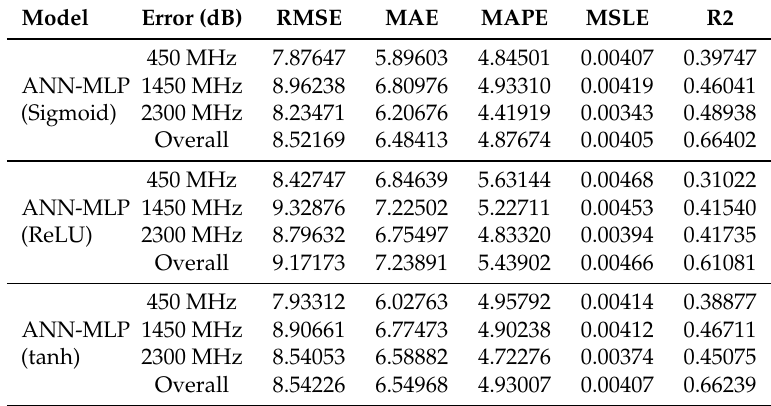
Table 2. Comparison of prediction accuracy of different metrics for Gaussian process